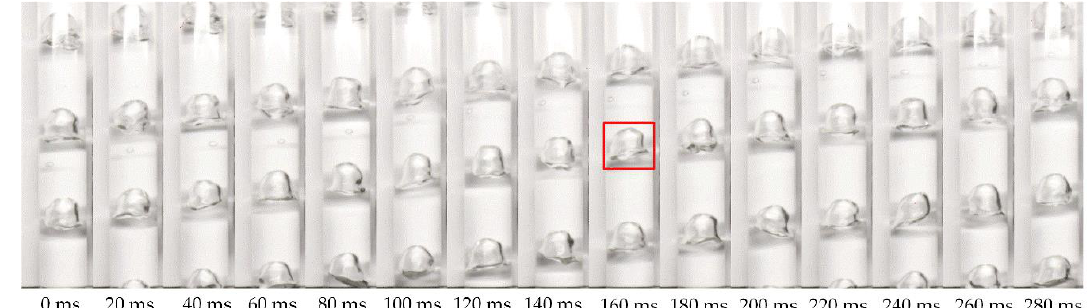
Figure 7. A series of images showing continuous captured bubbles.